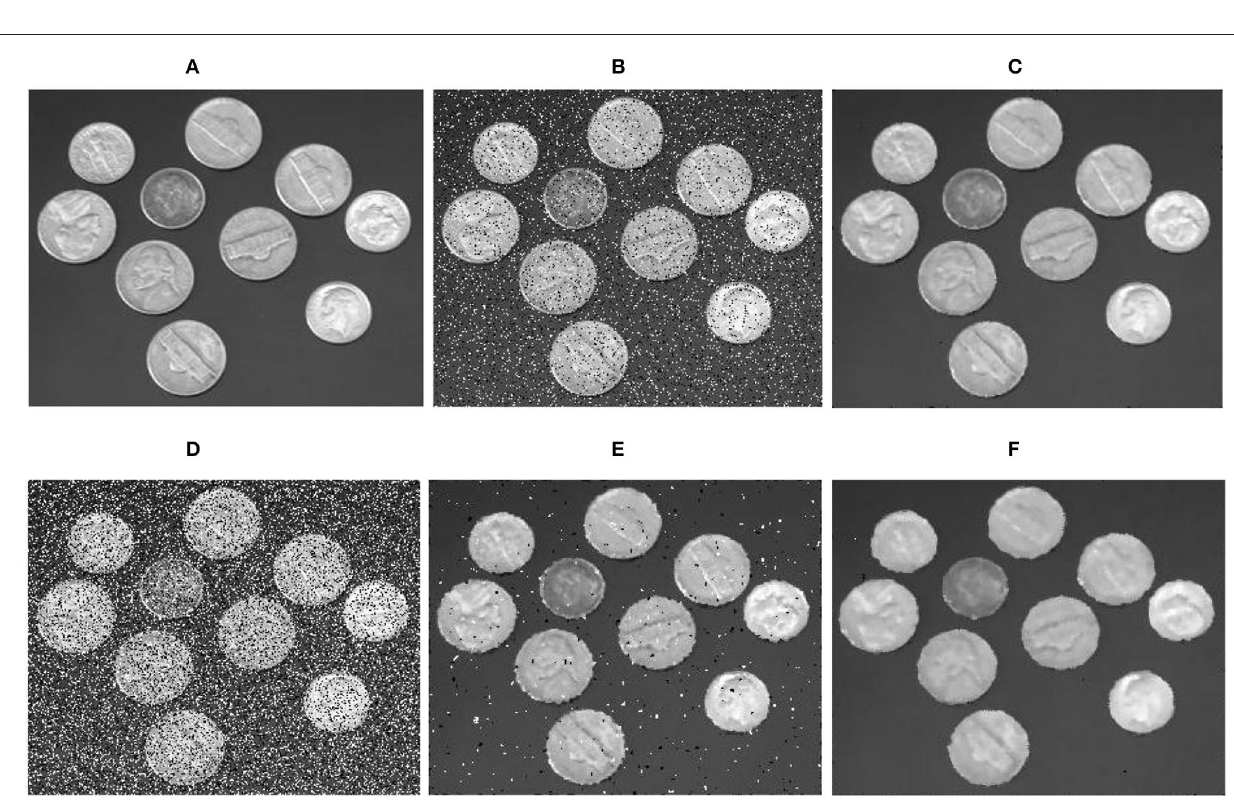
FIGURE 2 | (A) is the original image, (B) is the image polluted by salt and pepper noise with a density of 0.1, (C) is an image after median filtering with a window size of 3*3, (D) is an image polluted by salt and pepper noise with a density of 0.3, (E) is the image after median filtering with a window size of 3*3, and (F) is the image after median filtering with a window size of